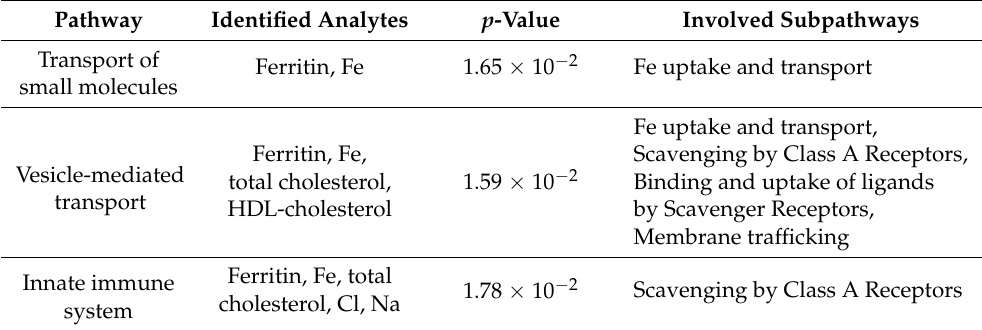
Table 3. List of the main significantpathways identified by the analysis on the Reactome database (Column 2); Student’s t -test: p < 0.01